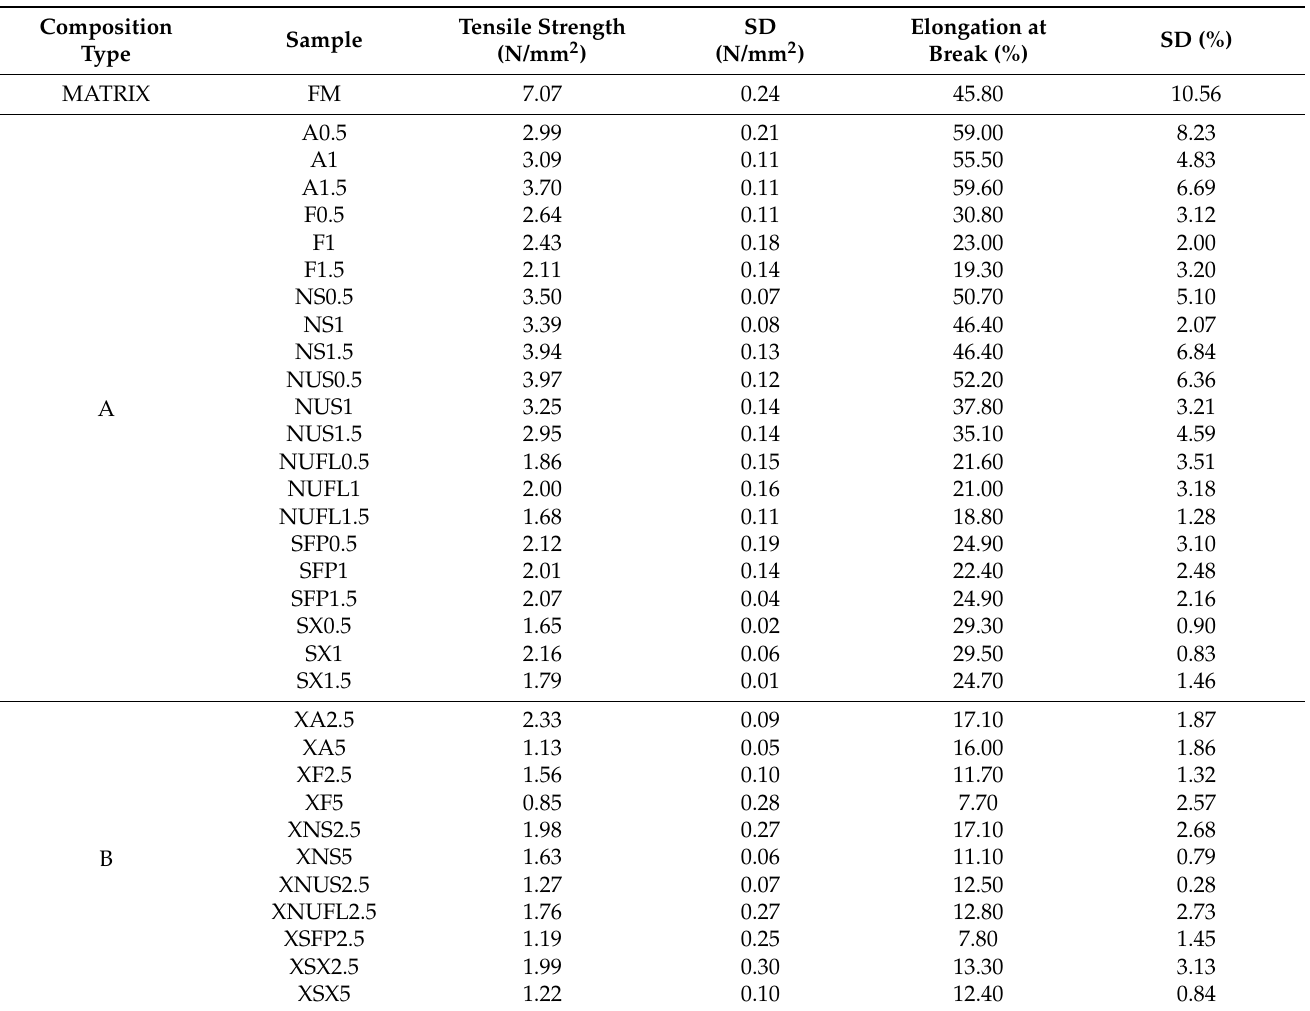
Table 3. Results of tensile